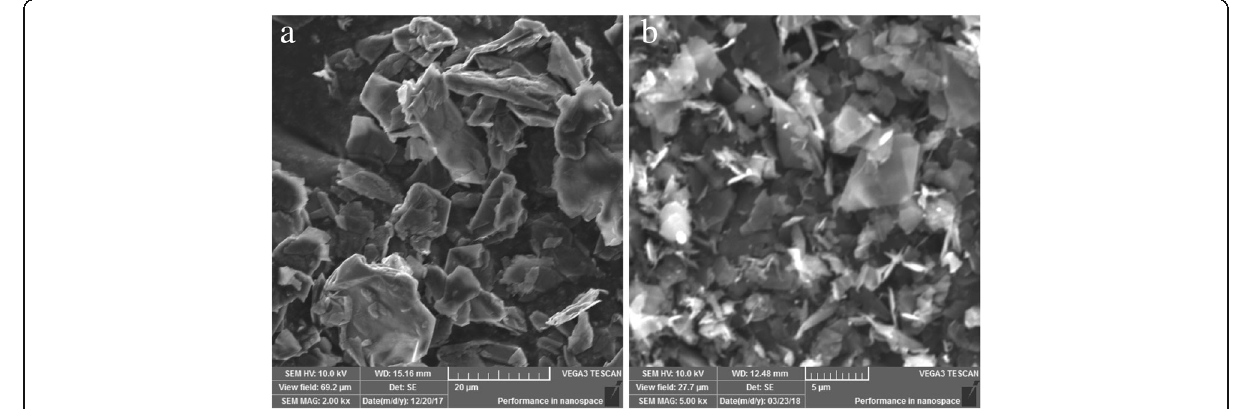
Fig. 3 SEM images of a the bulk graphite and b the prepared graphene